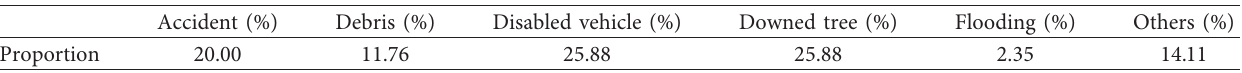
Figure 4: Sample results of the incident simulation. Table 5: Type of incidents during evacuation period simulated from models.